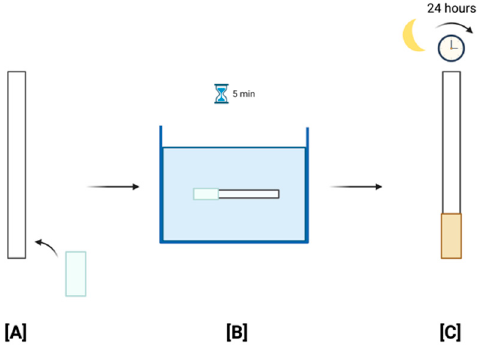
Figure 3. MTT-PMS test strip fabrication procedure: ( A ) Attachment of Whatman Fusion 5 TM paper test pad on ribbon strip; ( B ) Submersion of test strip in reagent for approximately 5 min; ( C ) Drying of the test strips in a dark room at room temperature for 24 h. Created with BioRender.com